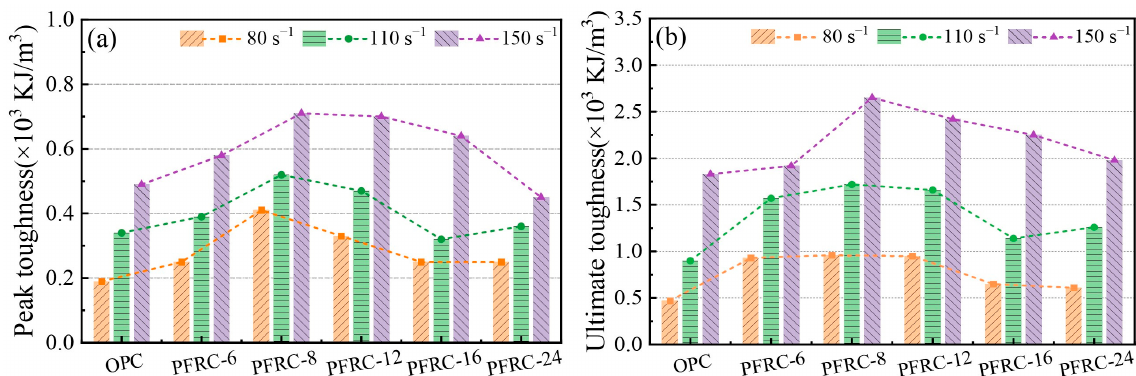
Figure 14. Impact toughness of specimens: ( a ) dynamic peak toughness and ( b ) dynamic ultimate Figure 14. Impacttoughnessofspecimens: ( a )dynamicpeaktoughnessand( b toughness.